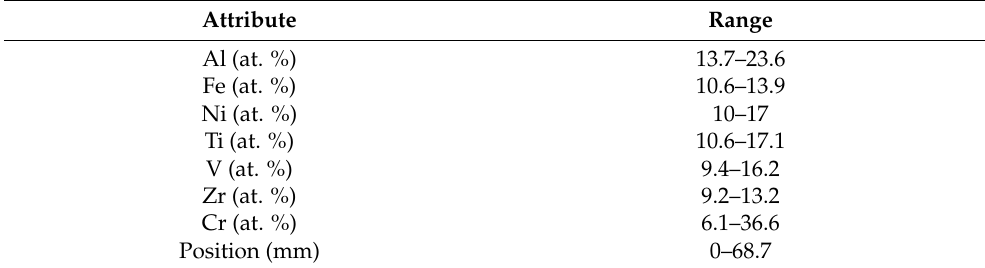
Table 1. Ranges of attributes from Ruiz-Yi et al.